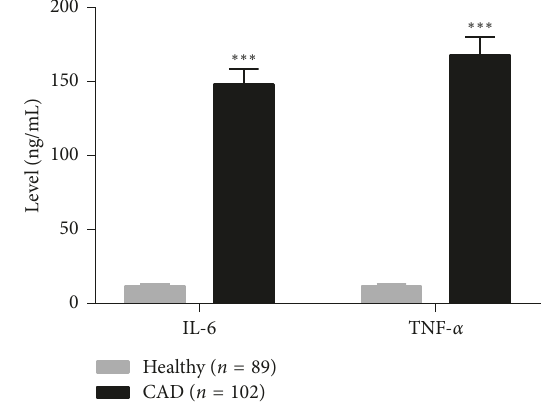
Figure 2: Level of serum IL-6 and TNF- α in patients with CAD and healthy controls. ∗∗∗ P < 0 .